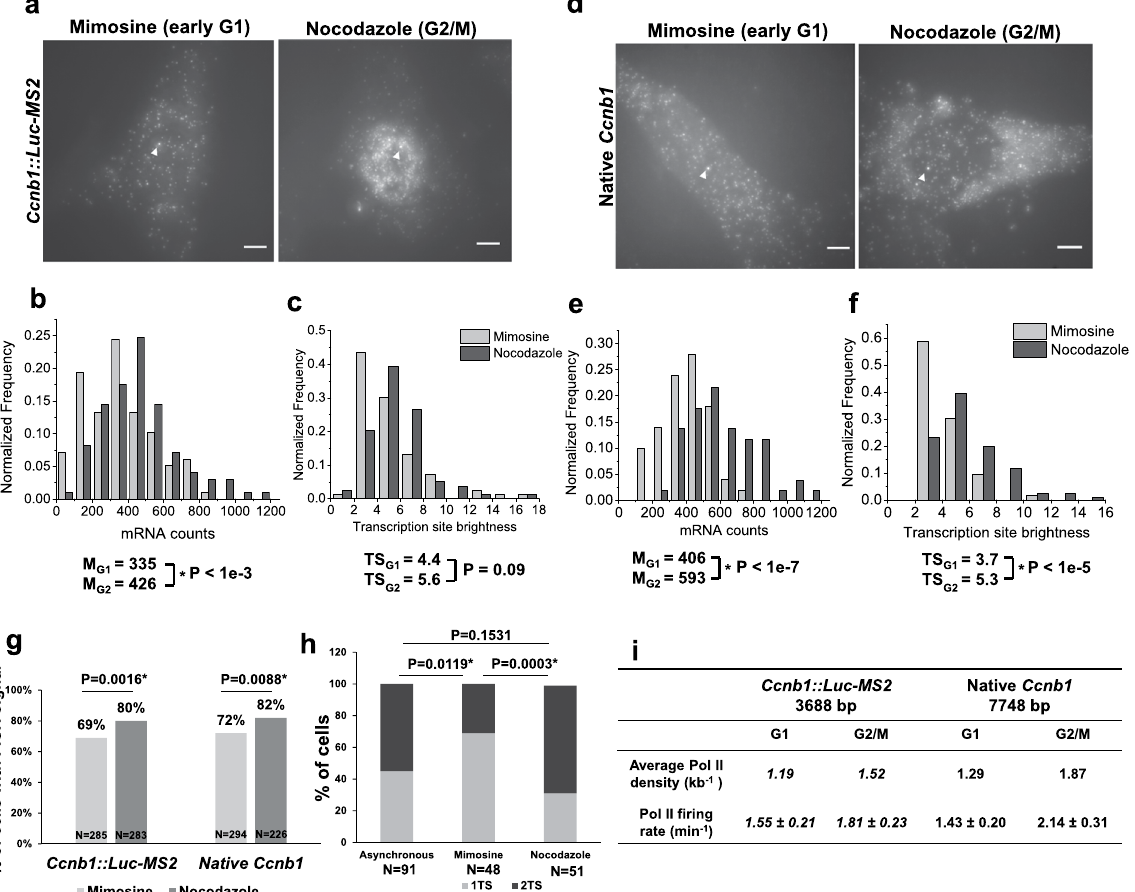
Figure 4. Expression of the Ccnb1 :: Luc - MS2 transgene mimics the native Ccnb1 gene during the cell cycle. ( a ) Representative single molecule RNA FISH images of the Ccnb1 :: Luc - MS2 transgene using MS2 probes in mimosine-treated or nocodazole-treated cells. Scale bars: 5 µ m. ( b , c ) Histograms and medians of mRNA counts ( b ) and TS brightness ( c ) of the Ccnb1 :: Luc - MS2 transgene. Measured cell number and TS number were 98 and 83 for mimosine-treated cells, respectively, and were 97 and 79 for nocodazole-treated cells, respectively. ( d ) Representative single molecule RNA FISH images of the native Ccnb1 gene in mimosine- treated or nocodazole-treated Ccnb1 :: Luc - MS2 (clone 96) cells. In panels a and d, images were taken at 120X magnification. White arrowheads indicate the TSs. Scale bars: 5 µ m. ( e , f ) Histograms and medians of native Ccnb1 mRNA counts ( e ) and TS brightness ( f ). Measured cell number and TS number were 50 and 63 for mimosine-treated cells, respectively, and were 51 and 86 for nocodazole-treated cells, respectively. In panels b, e and f, asterisks ( * ) indicate statistically significant differences in mean values of mRNA counts and TS brightness between mimosine-treated and nocodazole-treated cells determined by student’s t-test (P values are shown in each plot). ( g ) Fractions of cells expressing Luc - MS2 mRNA and native Ccnb1 mRNA in mimosine- treated and nocodazole-treated cells. ( h ) Fractions of cells with one or two active alleles of the native Ccnb1 gene in asynchronous, mimosine-treated and nocodazole-treated cells. In panels g and h, asterisks ( * ) indicate statistically significant differences between the experimental groups determined by Fisher’s exact test. ( i ) Table summarizing estimated RNA Pol II densities and firing rates of the Ccnb1 :: Luc - MS2 transgene and the native Ccnb1 gene in mimosine-treated and nocodazole-treated cells. Values derived from FISH data using MS2 probes are italicized. FISH images from one successful cell cycle arrest experiment were